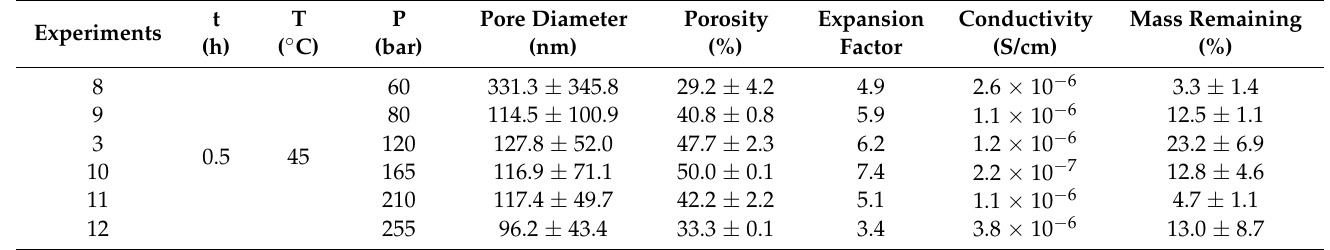
Table 2. Supercritical foaming experiments to evaluate the influence of pressure on the process.